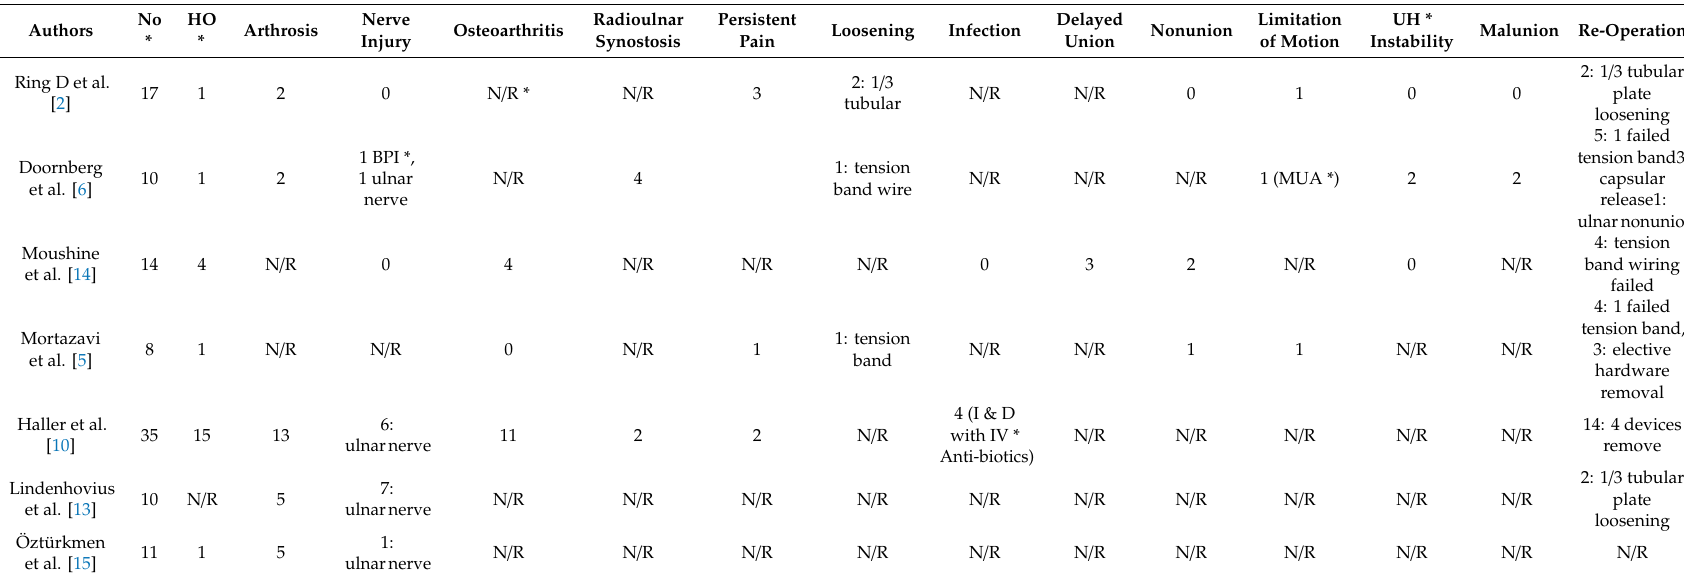
Table 3. Complications about trans-olecranon fracture